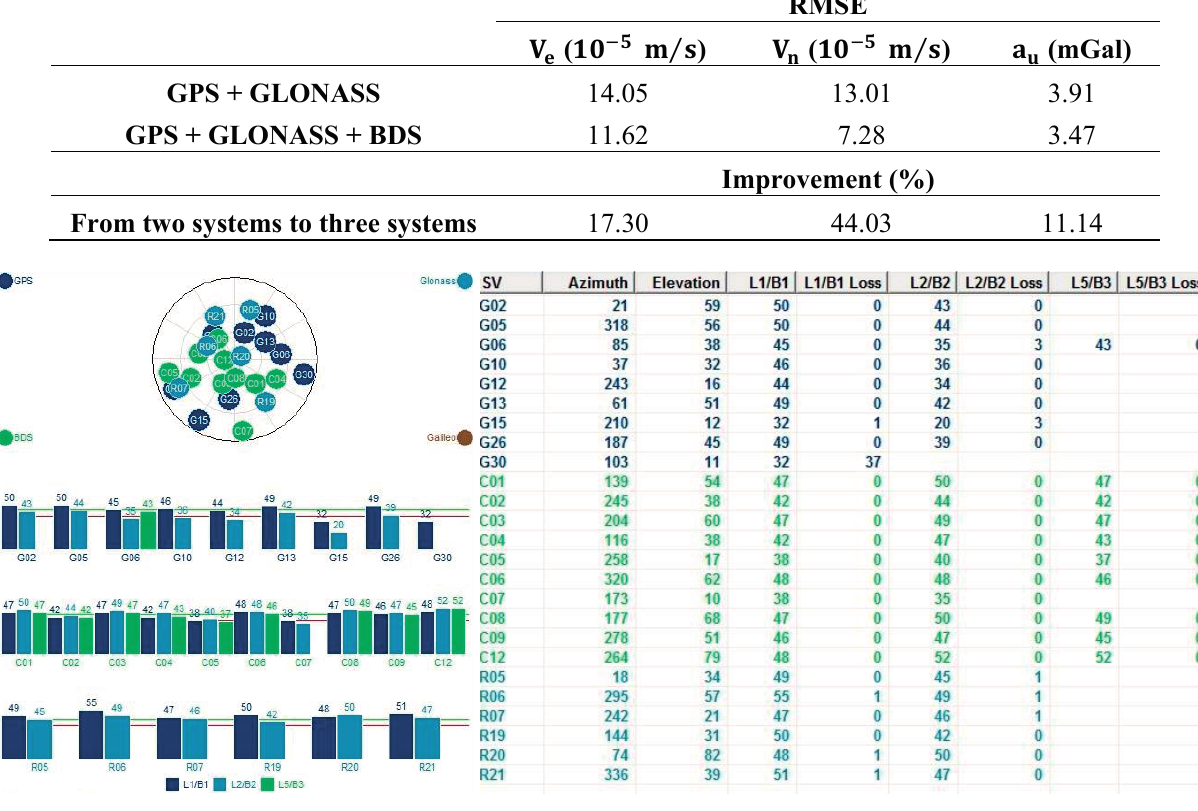
Figure 9. MB5000 software